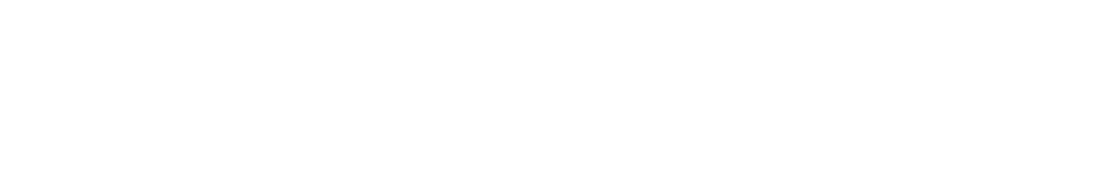
Frontiers in Energy Research |